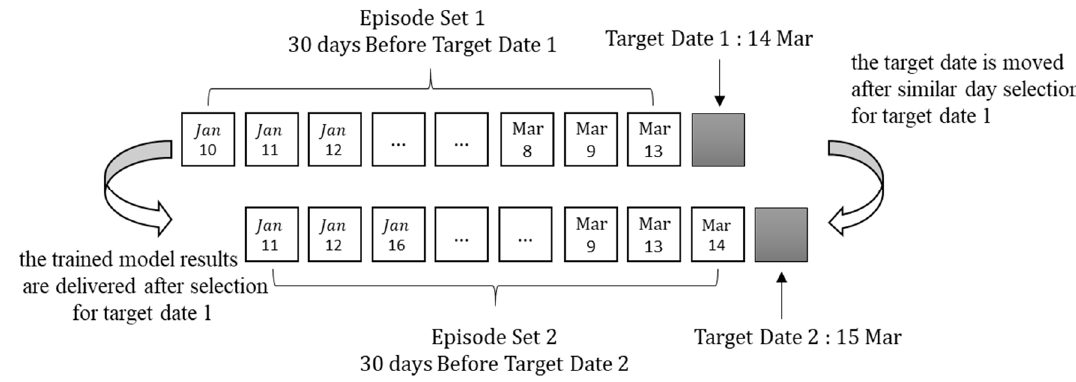
Figure 6. Range of the episodes according to the target date.